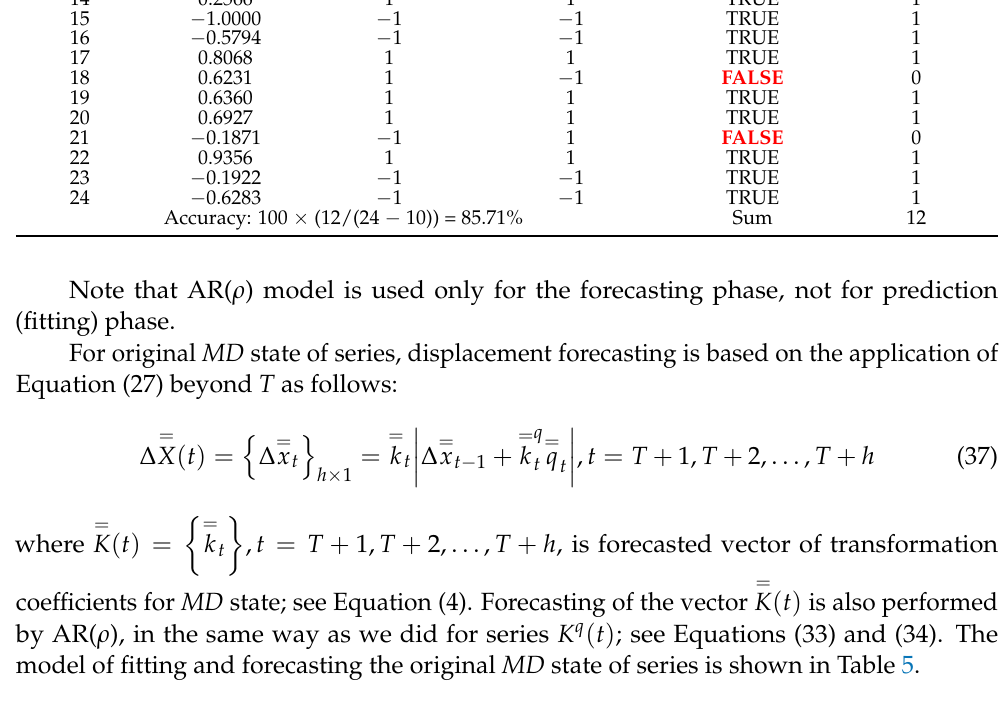
Table 5. Model of fitting and forecasting the MD state of series. Fitting Phase